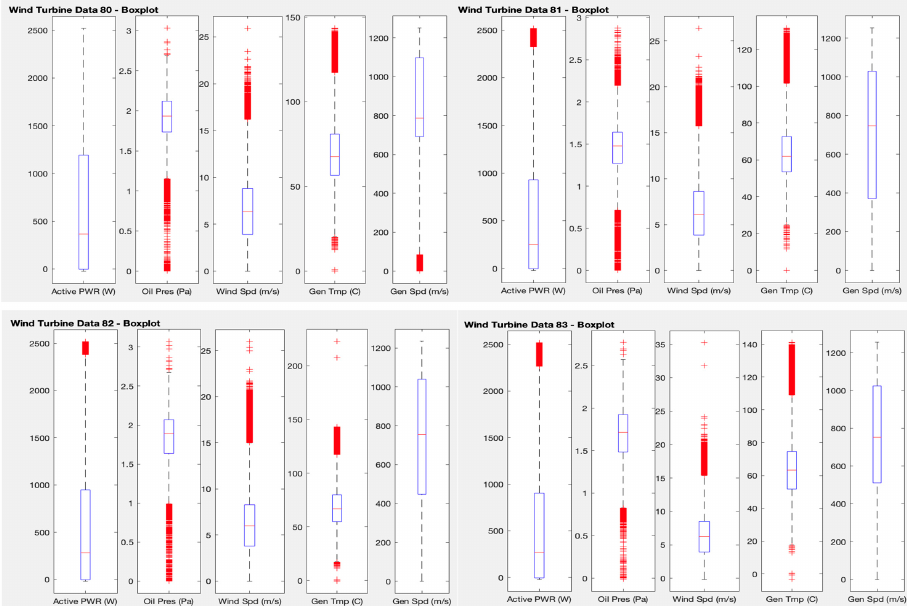
Figure 6. Test 4